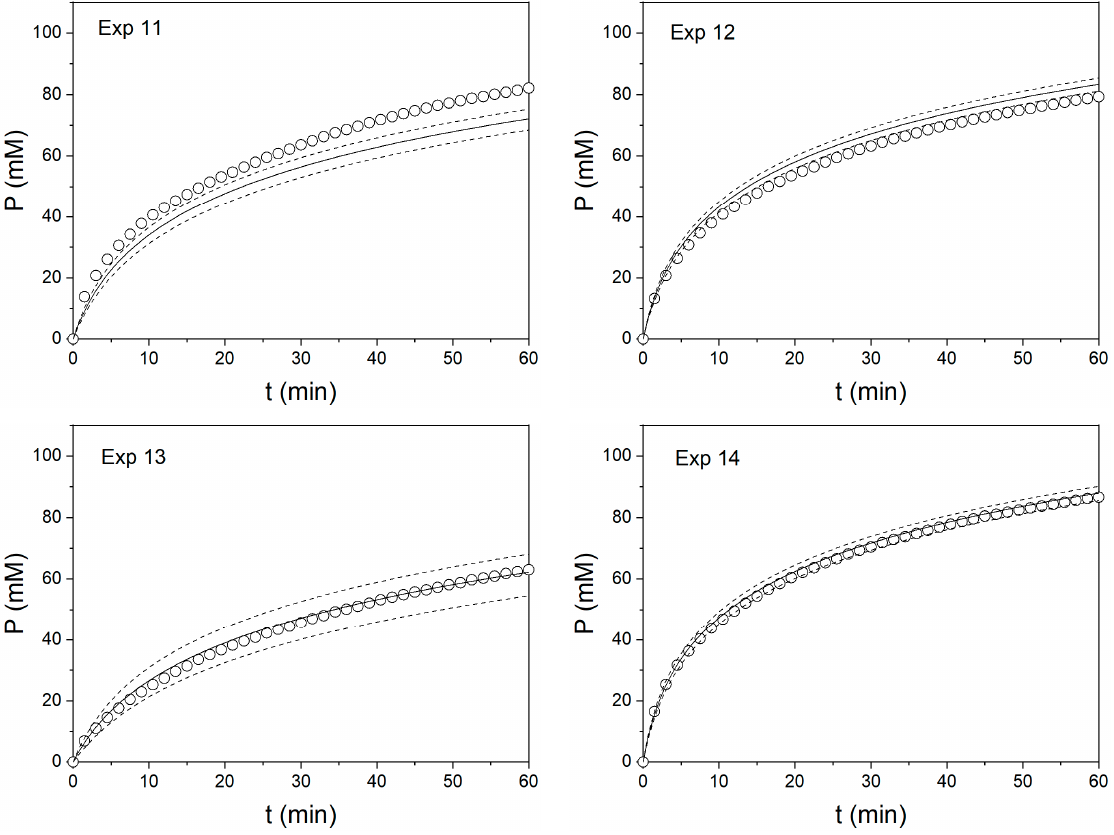
Table 7. Predicted and experimental values for DH after 60 min of milk protein hydrolysis from validation experiments with Alcalase and Protamex.